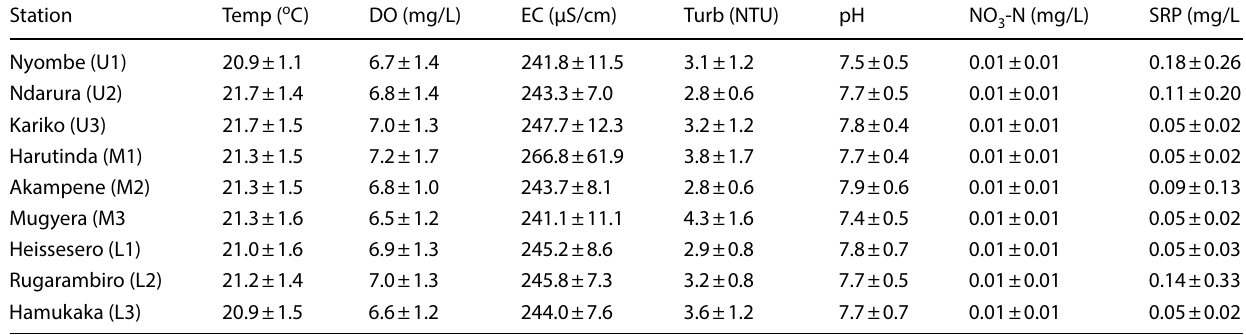
Fig. 2 Mean FIB counts across the different study